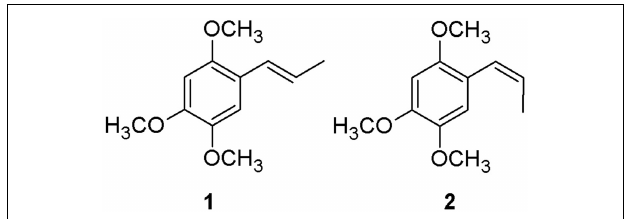
FIGURE 1 | Chemical structures of α -asarone (1) and β -asarone (2).